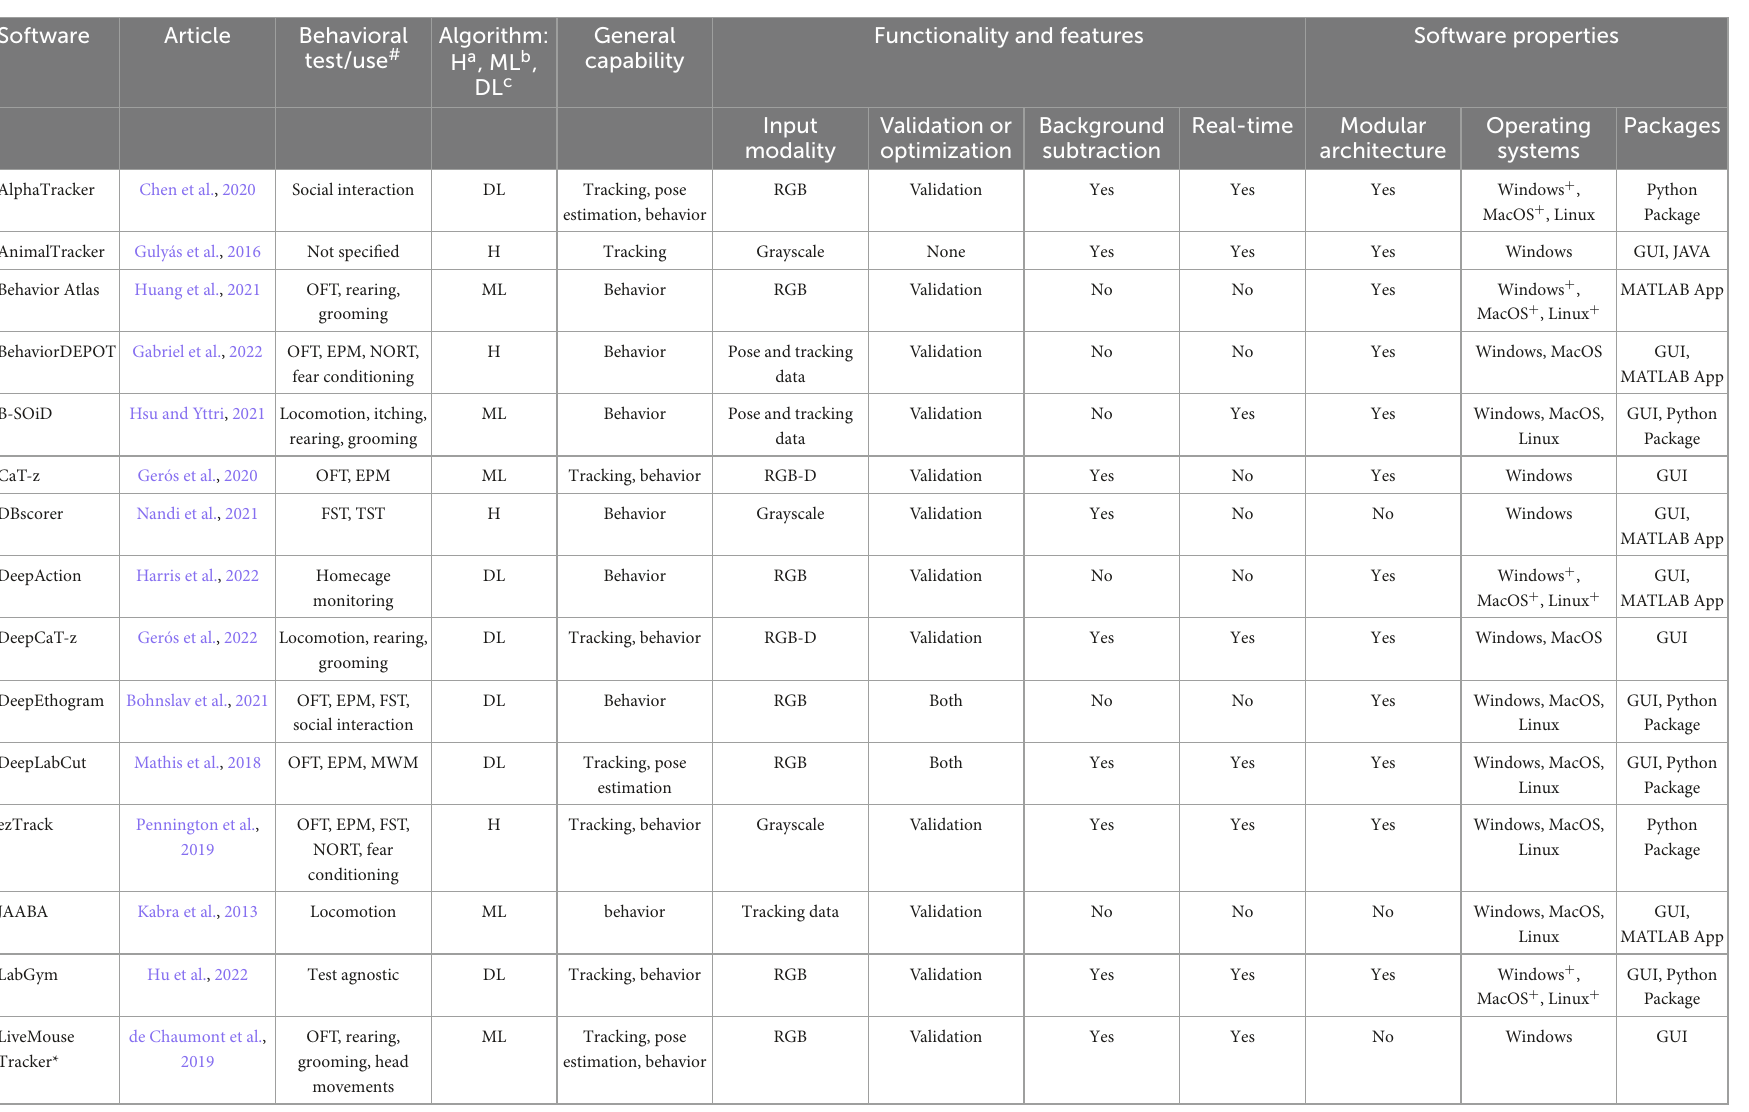
TABLE 2 Open-access and open-source behavioral analysis